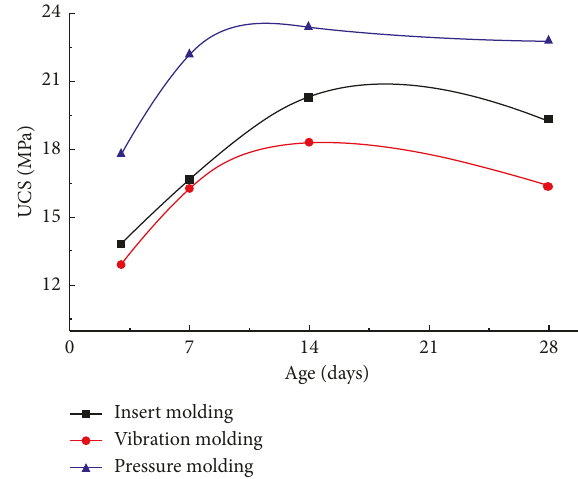
Figure 3: Compressive strength of different forming